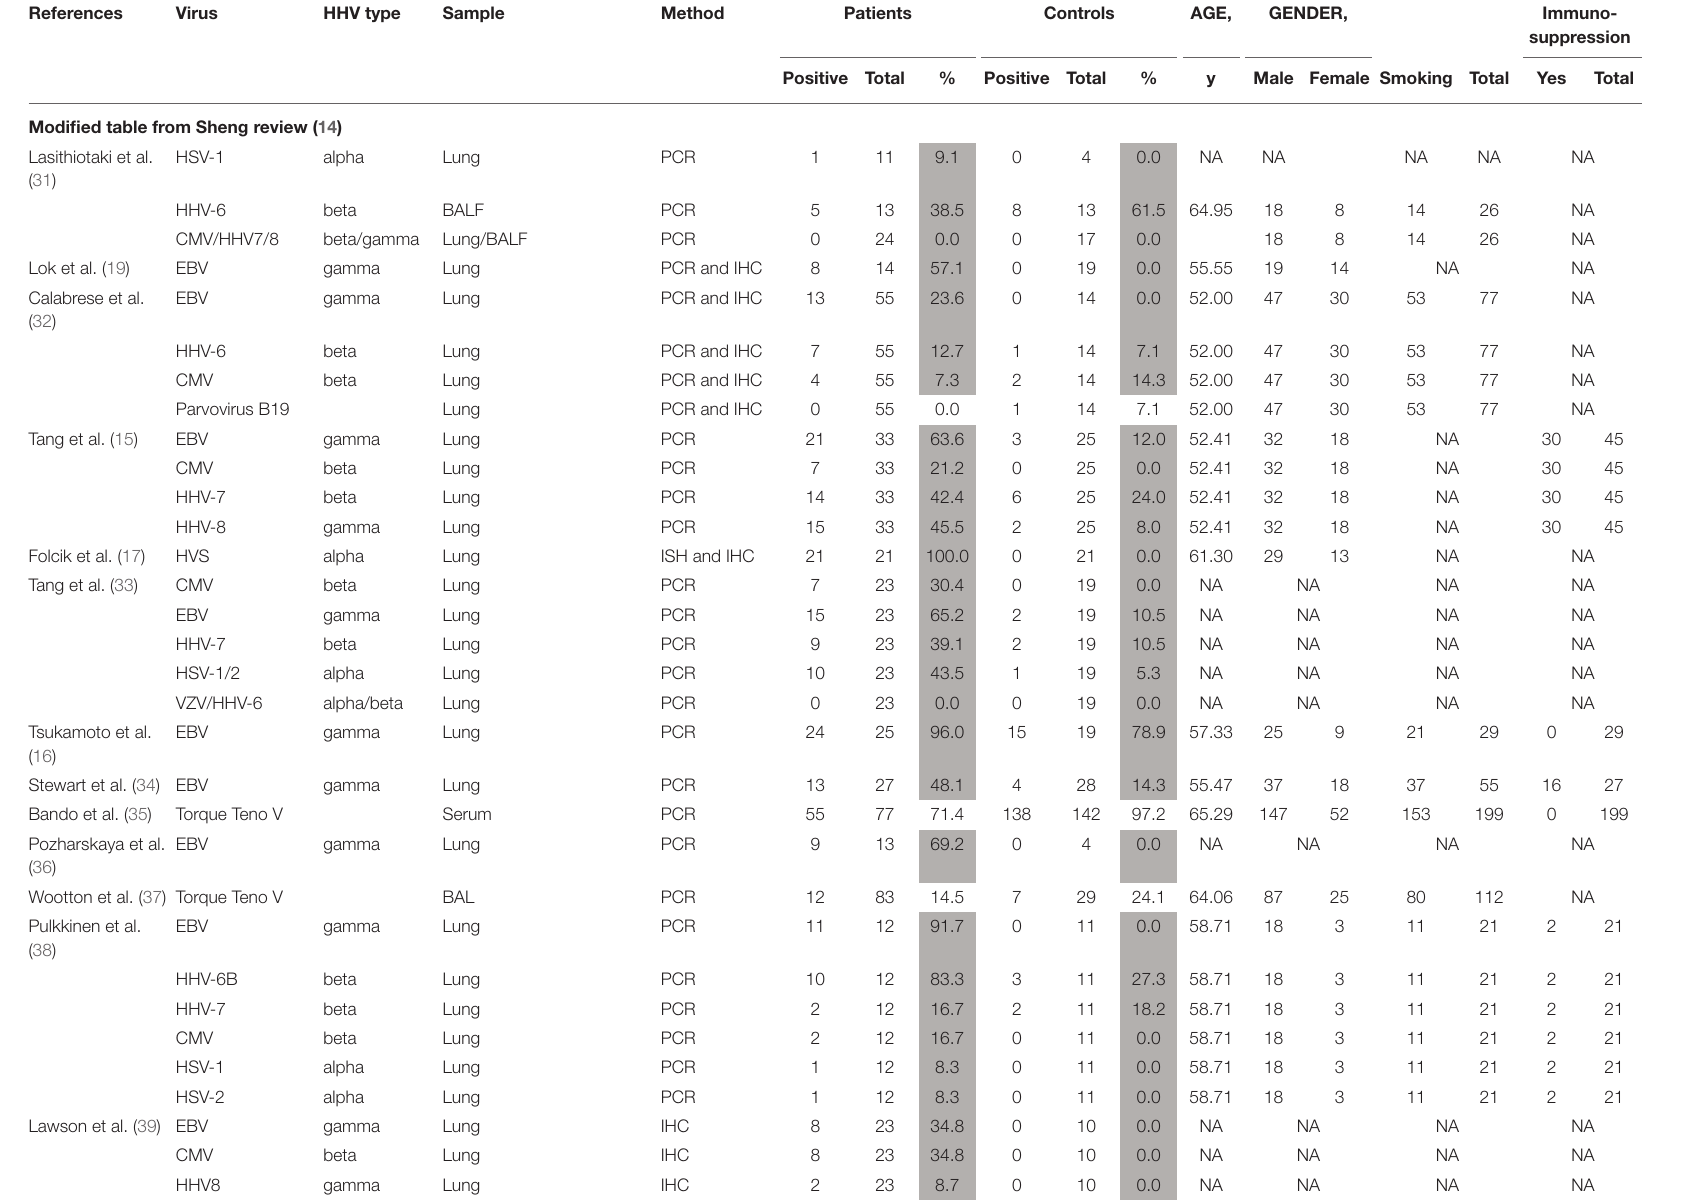
TABLE 1 | Studies of potential role of herpes viruses in pulmonary fibrosis: